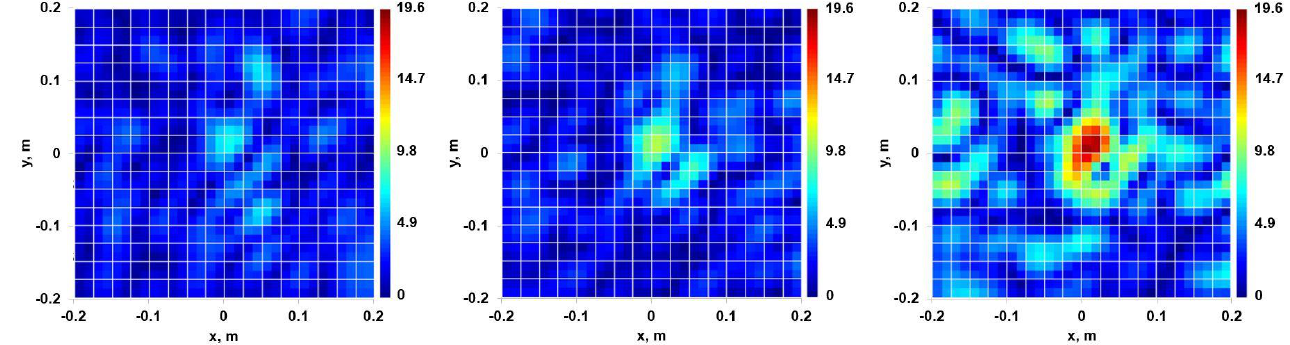
Figure 7. Holograms of reinforcement bar in sand at three different frequencies in the frequency range ∆ f ∼ 0.1, shown in a fixed amplitude scale.